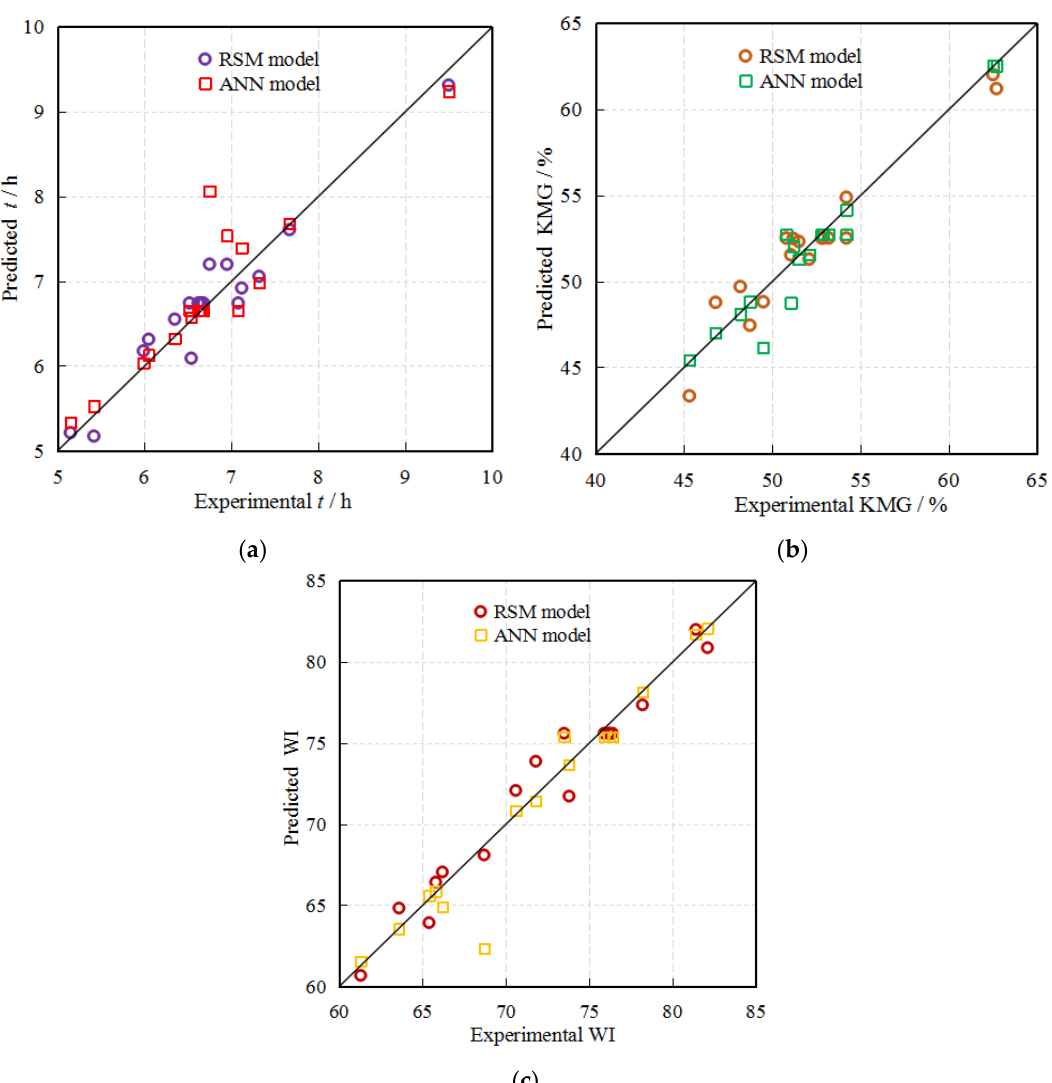
Figure 9. The training results of the 3-2-10-3 artificial neural network (ANN) model.